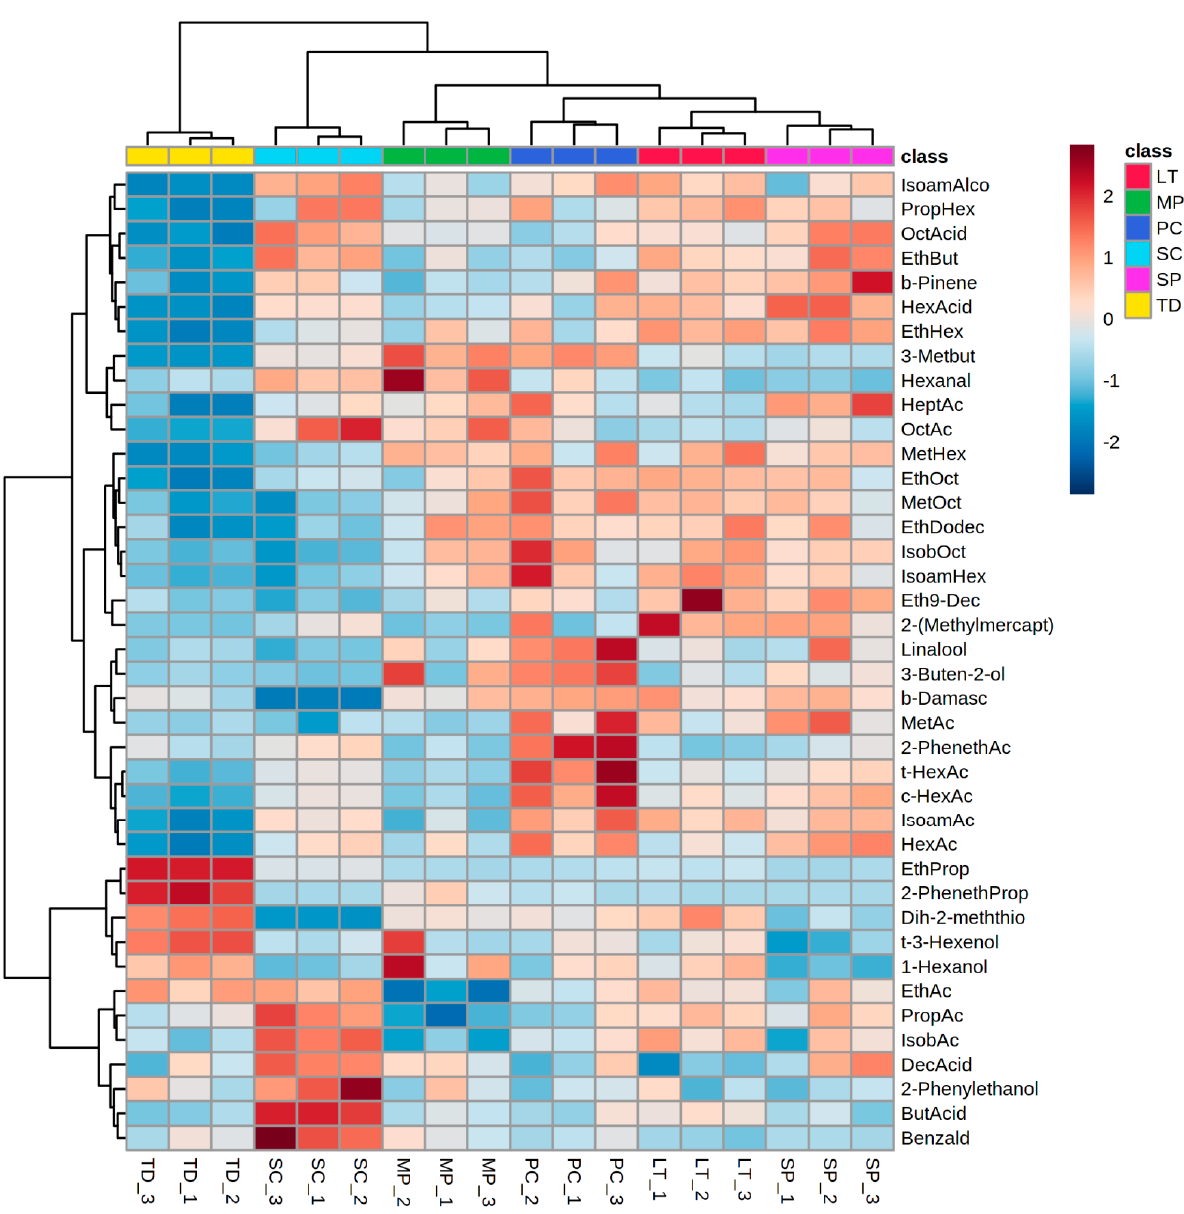
Figure 3. Hierarchical clustering analysis performed using volatile aroma compound composition of Malvazija istarska grape must in early fermentation by Saccharomyces cerevisiae and various non- Saccharomyces yeasts. The rows in the heatmap represent compounds, and the columns indicate samples. Colours of heatmap cells indicate low (dark blue), medium (white), and high (dark red) abundance of a particular compound. Abbreviations: IsoamAlco—isoamyl alcohol; PropHex—pro-